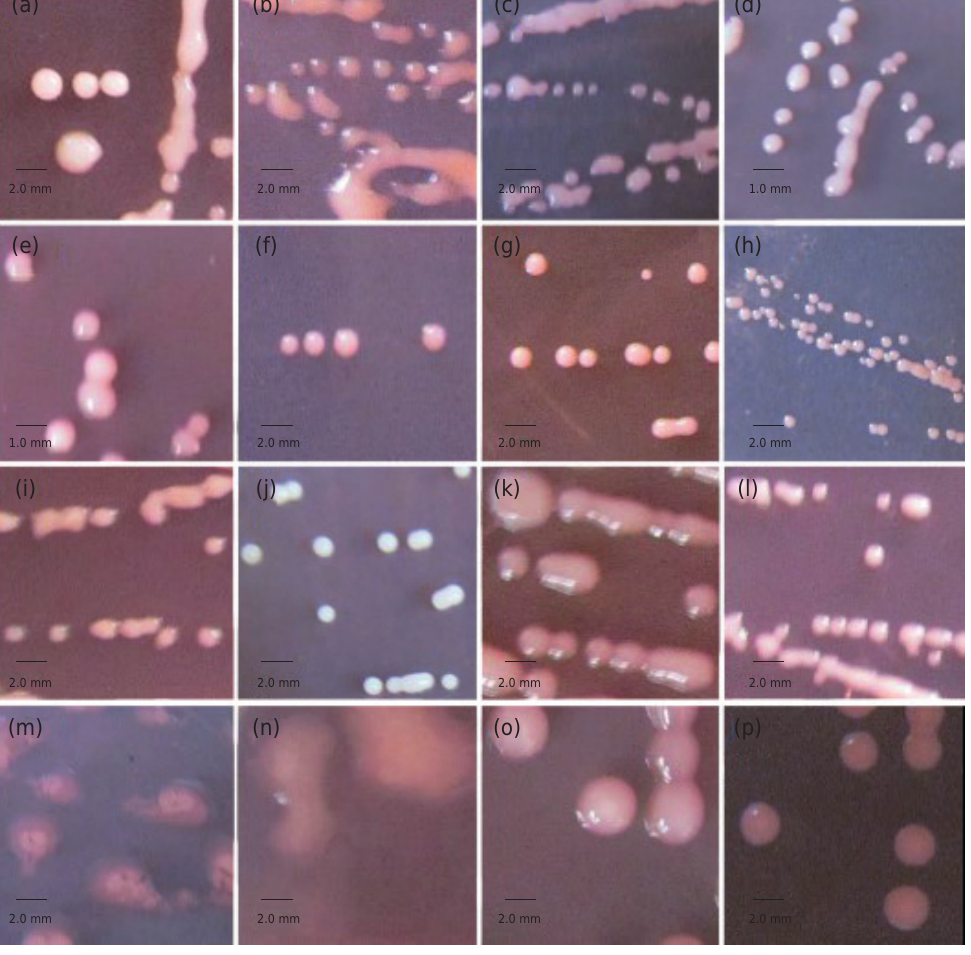
Figure 1. Morphological characteristics of the colonies in medium 79 with Congo red dye after 8 days of cultivation. UFLA 06-48 (a), UFLA 06-49 (b), UFLA 06-50 (c), UFLA 06-51 (d), UFLA